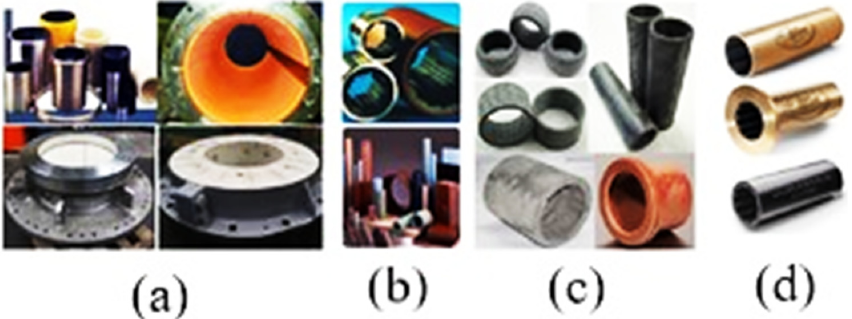
Figure 7. ( a ) Thordon bearing of Thomson–Gordon, ( b ) water-lubricated bearing material of Countrose, ( c ) Feroform bearing of TENMAT, ( d ) Johnson Cutless bearing of Duramax Marine [35].